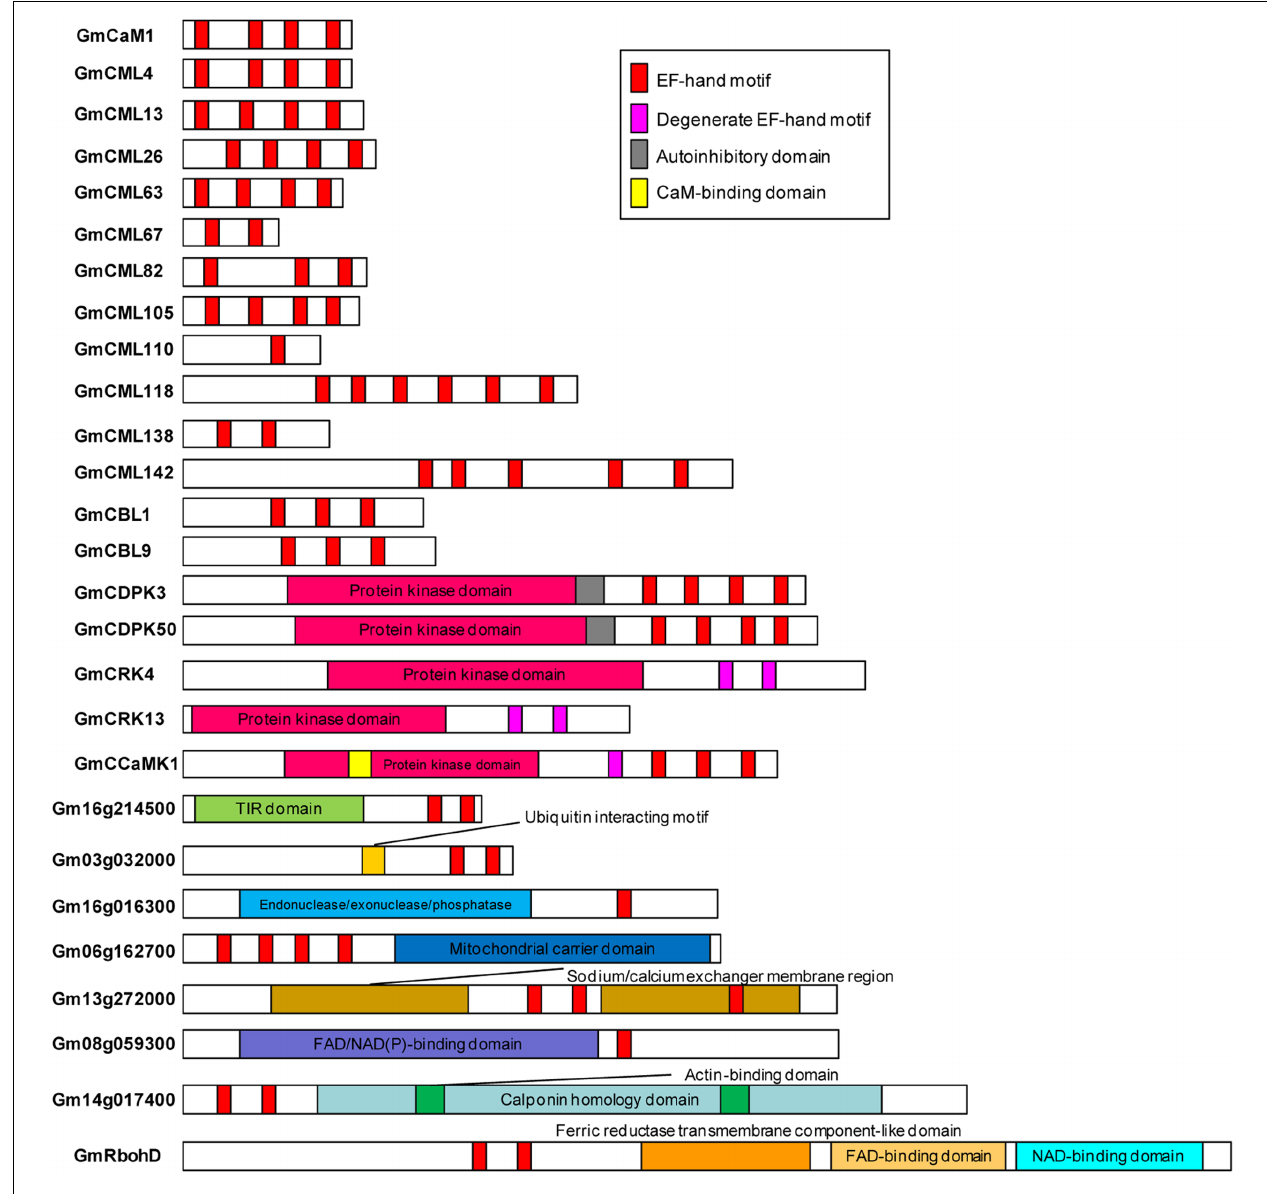
FIGURE 4 | Schematic diagrams of representative soybean EF-hand proteins. EF-hands and other domains were predicted using InterPro database (http://www.ebi.ac.uk/interpro/).